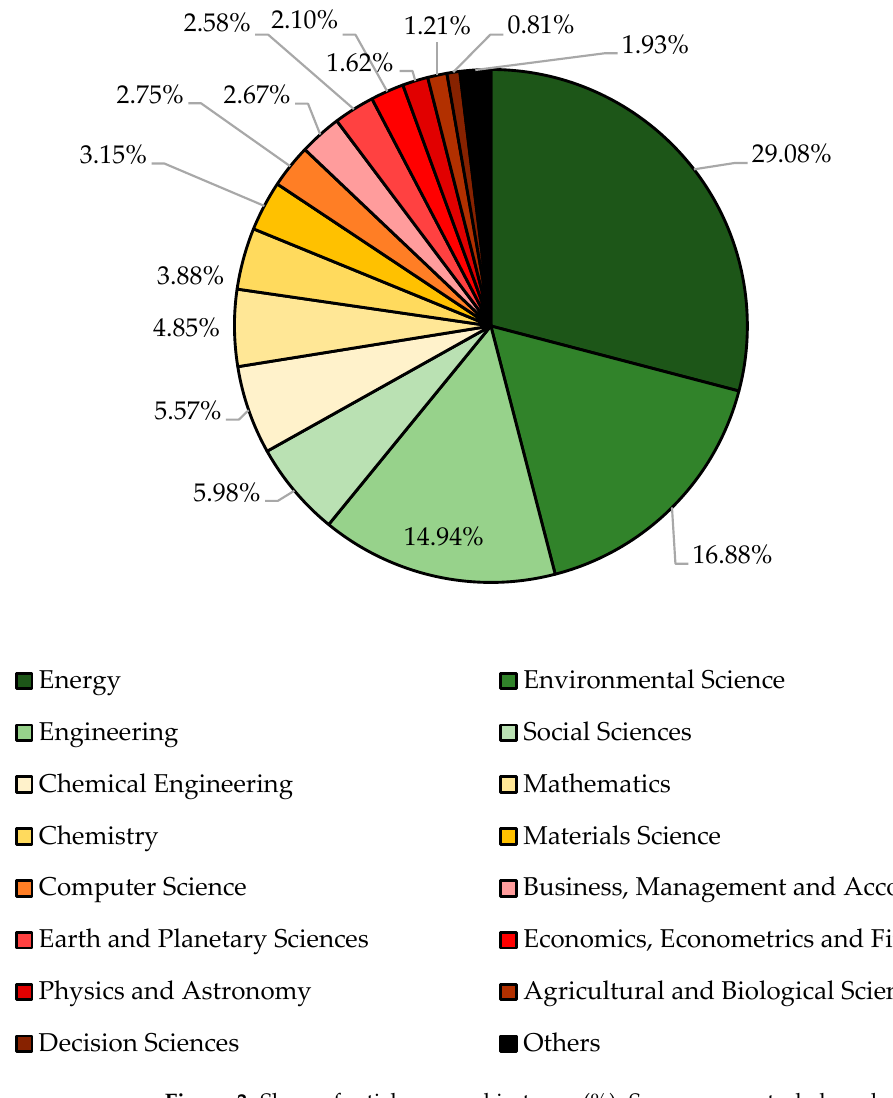
Figure 3. Share of articles per subject area (%). Source: own study based on: [33].